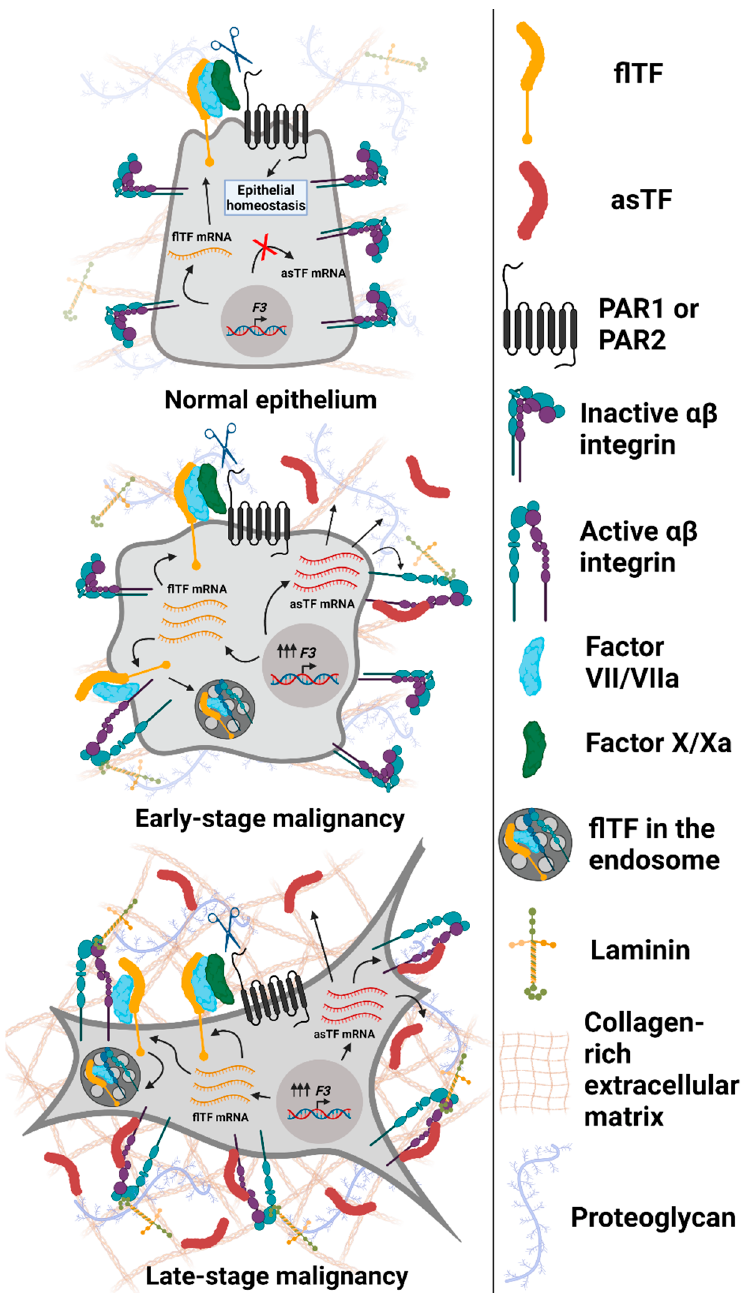
Figure 2. Expression and functional properties of Tissue Factor isoforms in normal and malignant epithelial cells. Top to bottom: normal epithelium (breast and/or pancreas) expresses maintenance (low) levels of flTF mRNA, which is translated into flTF protein that participates in cell/tissue homeostasis; asTF is not expressed. Early-stage transformed cells overexpress flTF as well as asTF. flTF protein activates αβ integrin subsets, promotes PAR-mediated signaling [21], and is recycled via endosomes as a means of cell-surface protein level regulation [39]. asTF activates α 6 β 1 integrins to promote cell proliferation and migration. In addition, asTF-dependent activation of α v β 3 on endothelial cells and their subsequent migration were observed [40]. As cancer progresses, asTF protein likely accumulates in tumor stroma, leading to the increased activation of integrins, fueling cancer cell proliferation, migration, and invasion. Not shown, asTF’s properties effected via endothelial cells that promote vessel growth and monocyte recruitment [40,41]. Image created with BioRender.com (accessed on 13 September